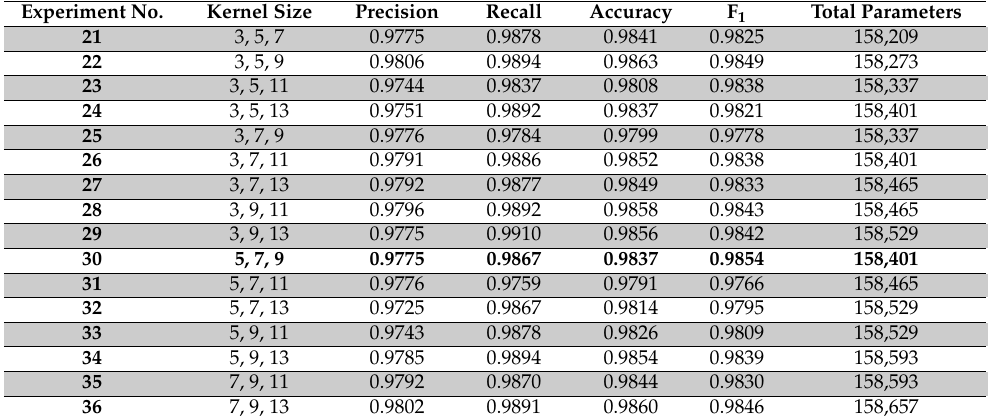
Table 9. Classification performance of the model for three scales with different kernel sizes. Experiment No.